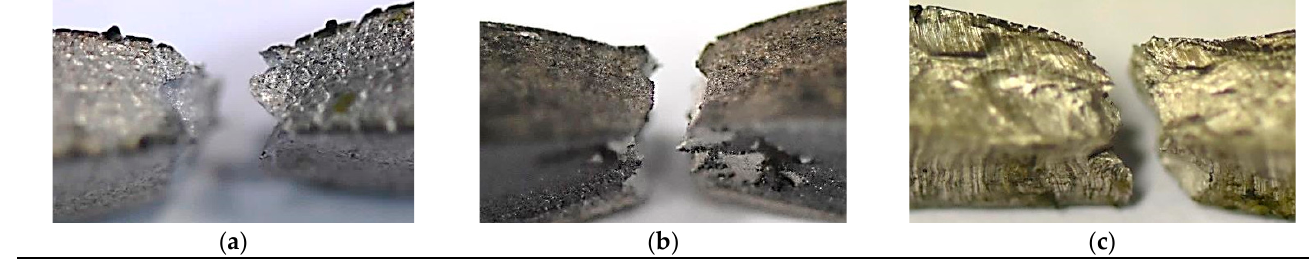
Figure 20. Geometrical differences in fracture zones at elastic–plastic deformation, with different degradation types: ( a ) multi-plane—Alloy 59, ( b ) double-plane—S355J2W+N steel and their MIG connection—one-plane ( c ).